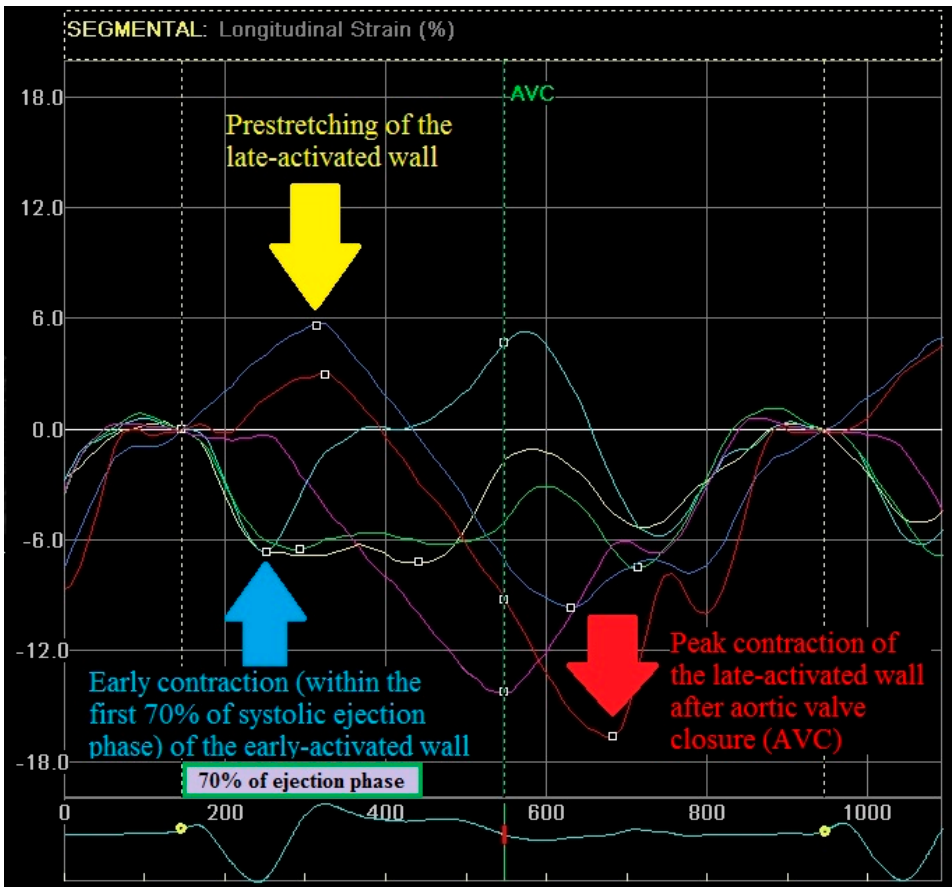
Figure 1. Components of Regional Strain Pattern Index (RSPI). Illustration of the four components of RSPI based on an analysis of the 4-chamber apical view strain curves: 1) the early contraction of the early-activated wall (light blue line; light blue arrow); 2) the prestretching of the opposing, late-activated wall (blue line, yellow arrow); 3) the contraction of the early-activated wall occurs in the first 70% of the systolic ejection phase and 4) the peak contraction of the late-activated wall occurs after aortic valve closure (red line, red arrow). AVC indicates aortic valve closure.